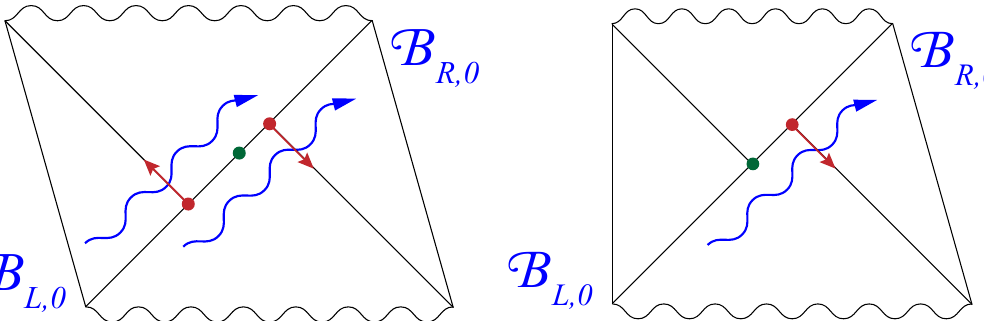
Figure 7 . In the natural frame for H A , an operator b k ∈ B R, 0 creates a high energy shock and hence a large separation between the left black hole horizon and the right white hole horizon. The left white hole horizon and right black hole horizon coincide in this frame up to perturbative corrections. Left: generically, the quantum extremal surface (green) lies on this horizon in between the left and right causal surfaces (red); the red arrows show the direction of increasing generalized entropy on the causal surfaces. The QES and both causal surfaces have approximately the same generalized entropy. Right: if the operator b k is unitary, then the modes in B ‘, 0 remain in the Hartle-Hawking state, and the left causal surface is itself